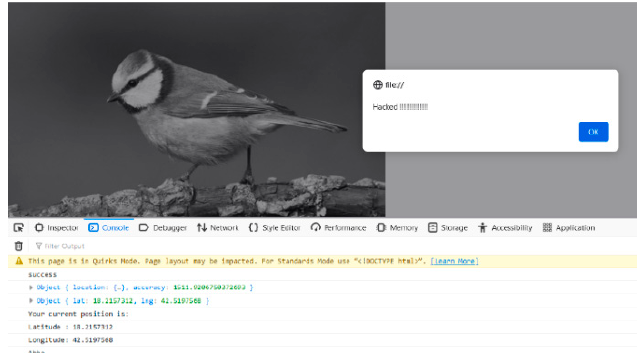
Figure 10. Exploit triggered in Firefox browser.